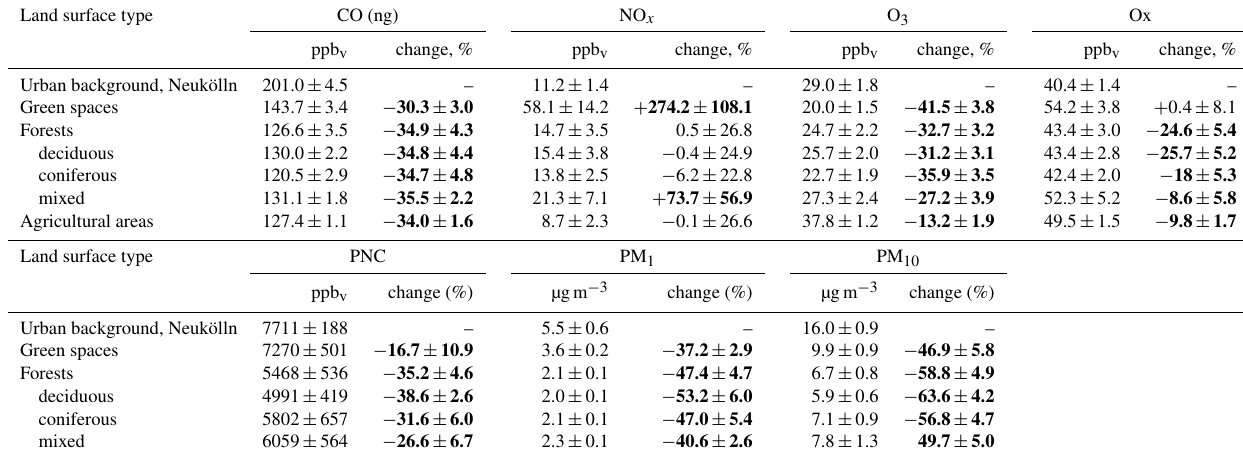
Table 9. Effect of different vegetated areas on the median amount of atmospheric pollutants ± 5% quantiles and their change in Berlin during BAERLIN2014. Bold numbers of changes represent statistical significance by 95%. Gaseous pollutants are listed at the top and particulate values based on bicycle observations at the